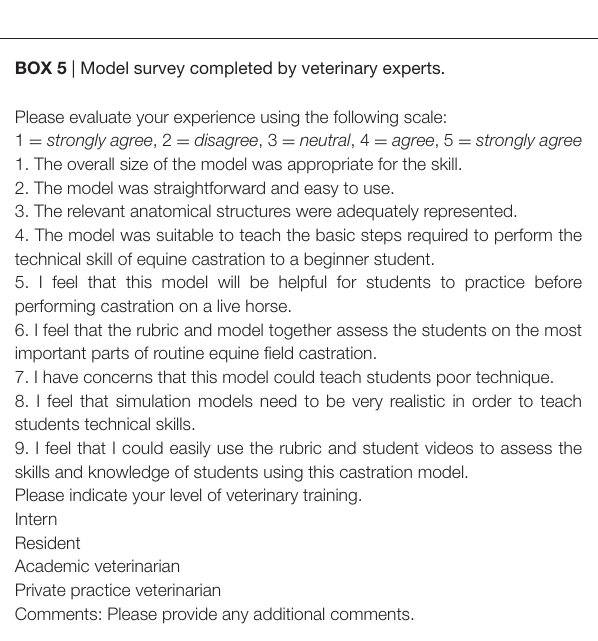
TABLE 1 | Student groups based on previous castration experience. Tier Tier I Student has not previously removed any testicles from a live horse. Student has previously removed 1-2 testicles from a live